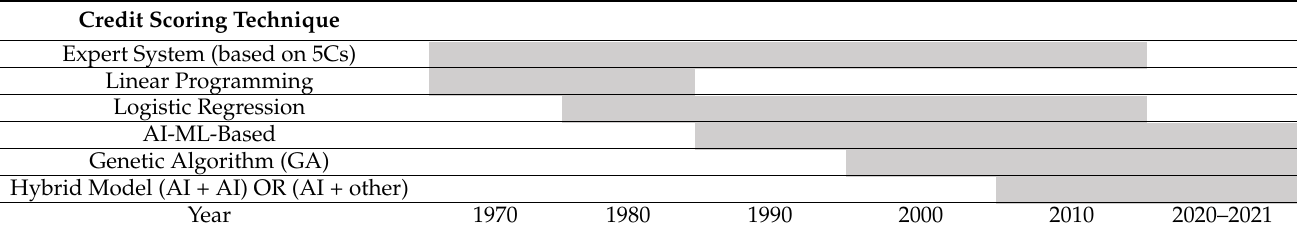
Table 3. Credit scoring technique (widely adopted for credit scoring—decade